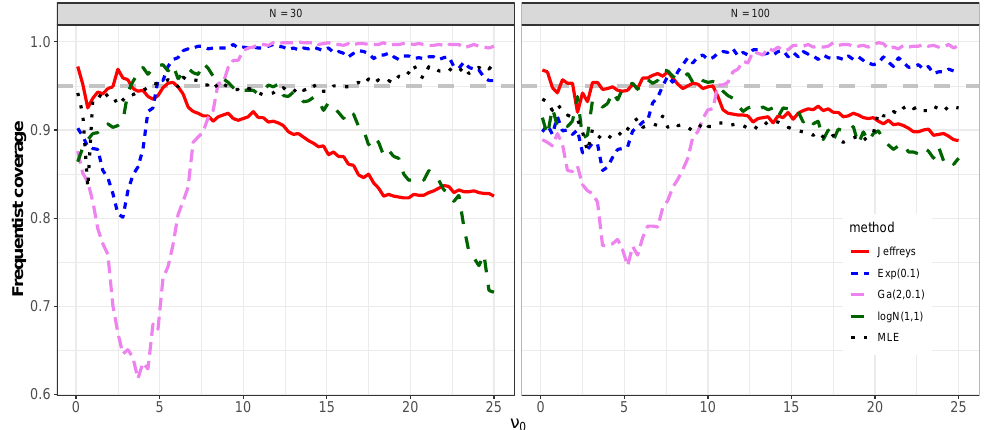
Figure 6. Frequentist coverage of 95% credible intervals for the degrees of freedom based on the four priors ( π J ( ν ) (4), π E ( ν ) (5), π G ( ν ) (6), and π L ( ν ) (7)) for sample sizes N = 30 and N = 100. The 95% bootstrap confidence interval based on MLE of ν is used to describe the 95% coverage for the frequentist